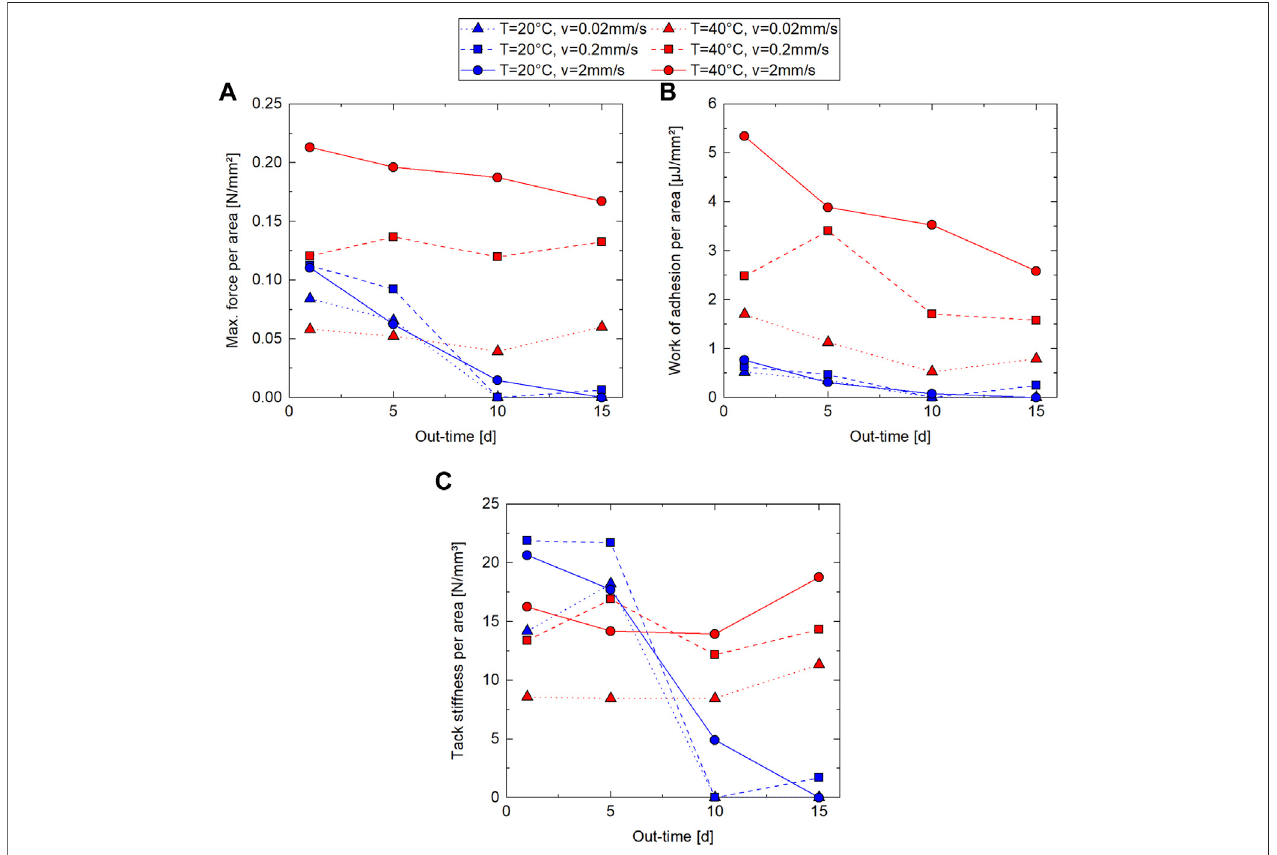
FIGURE 7 | Probe tack results as a function of out-time from rheometer probe tack tests (Material: IM7/8552 prepreg; out-time: 1 day – 15 days at T (cid:1) 21 ° C , RH (cid:1) 40 % ). (A) Maximum force. (B) Work of adhesion. (C) Tack stiffness.